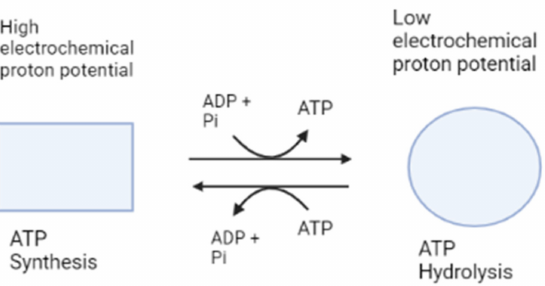
Figure 2. Simplified ATP synthase mechanism of action. This figure shows the two functions of ATP synthase, represented as different shapes, synthesis and hydrolysis of ATP. Made with BioRender. Similarly to the bacterial ATPase, the mitochondrial enzyme consists of two domains, F1 and F0. The F1 domain is located outside the mitochondrial membrane and